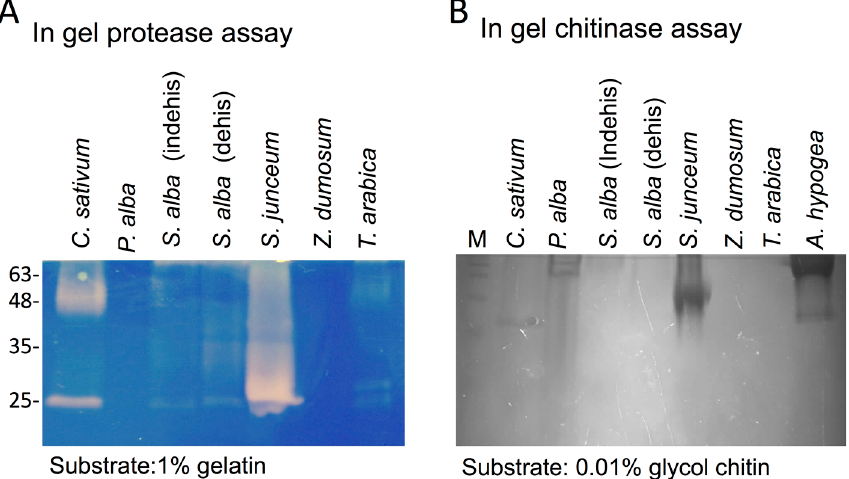
Figure 3. Dead pericarps of various plant species store and release proteases and chitinases. ( A ) In gel protease assay. Pericarps derived from C. sativum, P. alba , S. alba , S. junceum , Z. dumosum and T. arabica, were extracted (10 mg) with 100 µ L of PBS buffer at 4 ◦ C for 12 h and substances released were examined for protease activity toward 1% gelatin. ( B ) Detection of active chitinases by in gel chitinase assay. Pericarps of C. sativum , P. alba , S. alba , S. junceum , Z. dumosum , T. arabica and A. hypogea were extracted (10 mg except that 1 mg was used for S. junceum ) with 100 µ L of 0.1 M NaHPO 4 (pH = 6) at 4 ◦ C for 8 h and substances released were examined for chitinase activity towards 0.01% glycol chitin. M, molecular weight protein markers (in kDa).